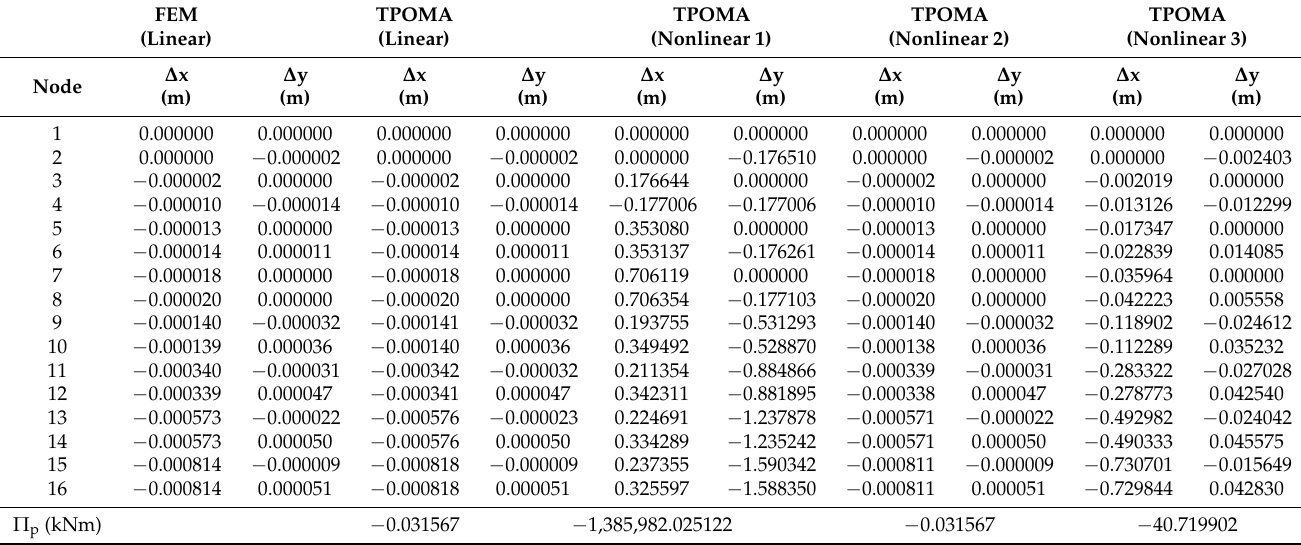
Table 7. Solutions for the system with 14 members